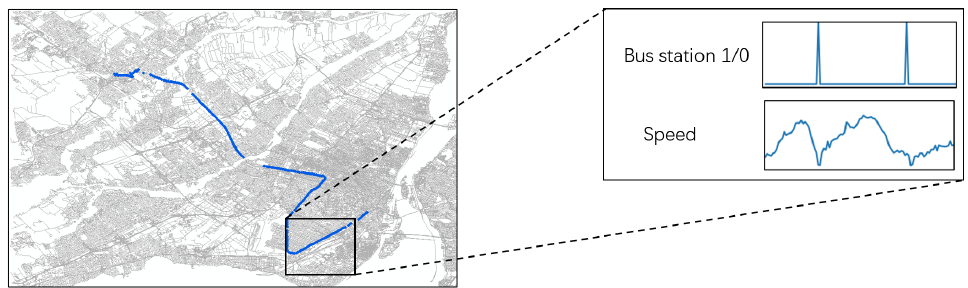
Figure 1. The effect caused by the location of a bus station on a